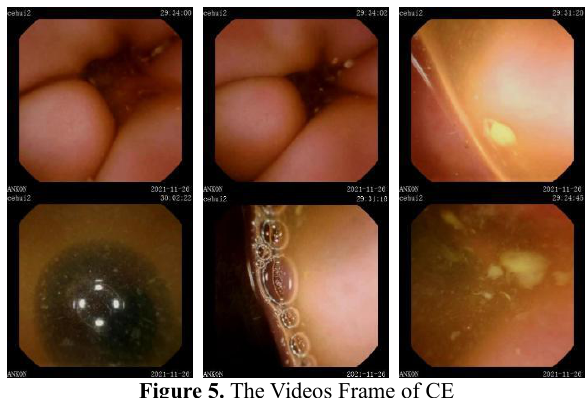
Figure 5. The Videos Frame of